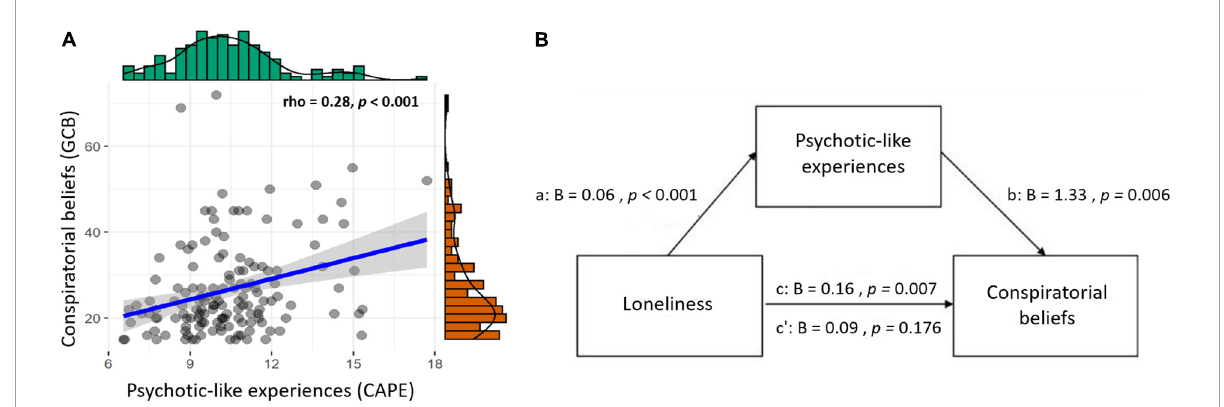
FIGURE2 Associations between loneliness, psychotic-like experiences (PLEs) and conspiratorial beliefs. (A) Significant positive correlation between conspiratorial beliefs and PLEs (rho = 0.28, p < 0.001); (B) Mediation model with loneliness as predictor and PLEs as mediator predicting conspiratorial beliefs. Betas are unstandardized, total effect (c), direct path